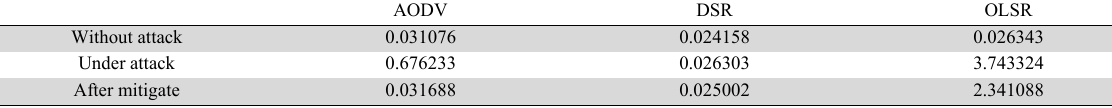
Fig. 5. End-to-End delay for each protocol in different scenarios End-to-End delay for each protocol in different